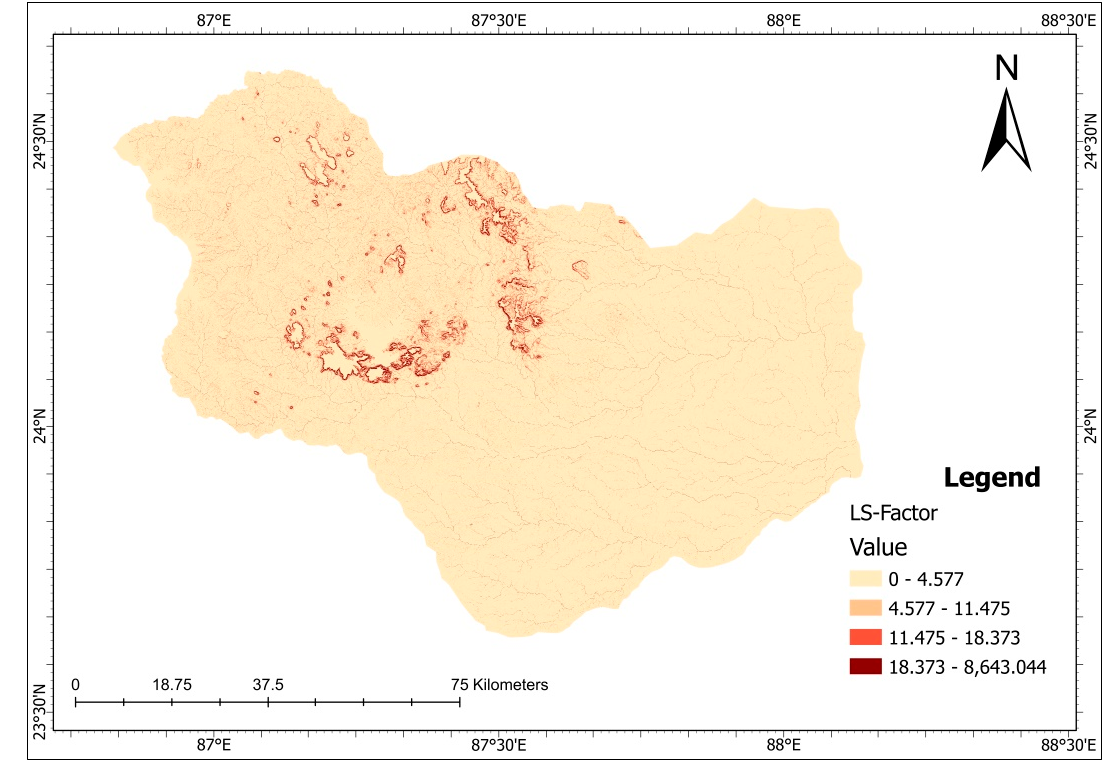
Figure 9. Topographic Factor (LS) map.